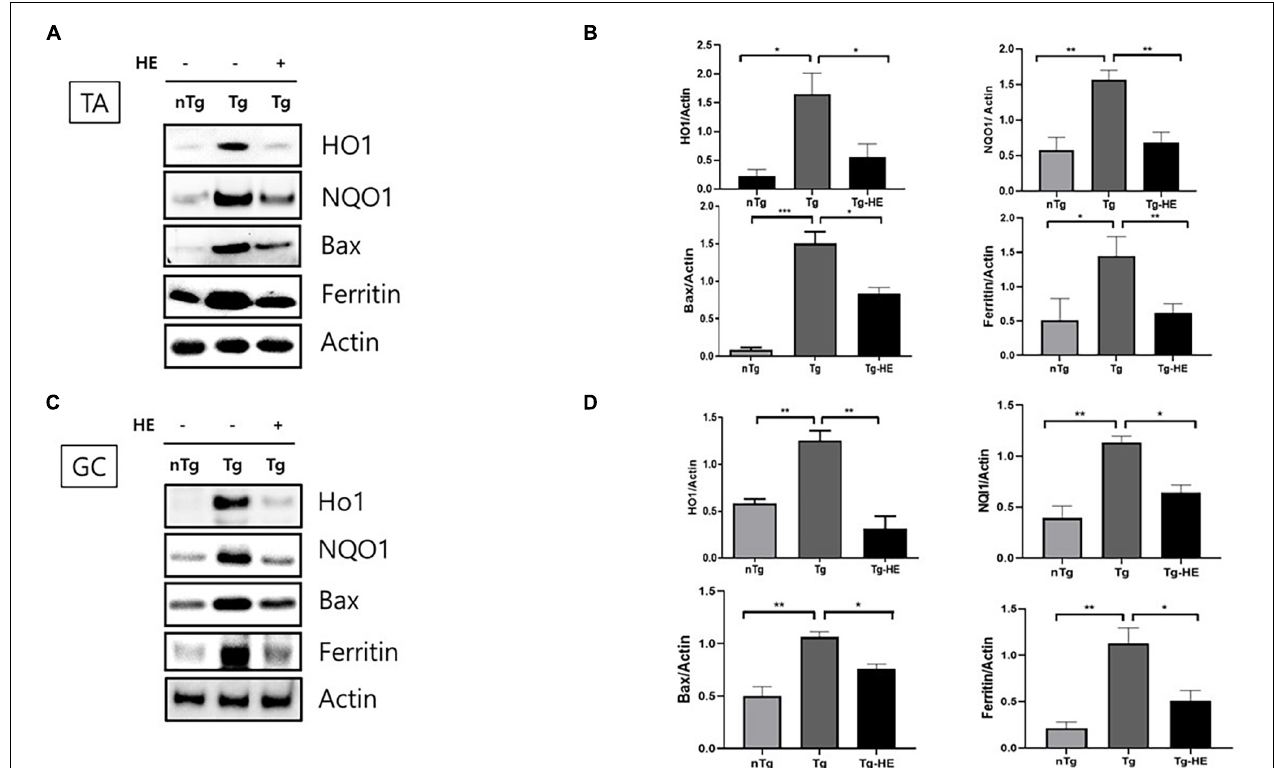
FIGURE 3 | Herbal extract (HE) reduces oxidative stress in the muscles of hSOD1 G93A mice. Representative data for Western blotting analysis of HO1, NQO1, BAX, and ferritin in the (A) tibialis anterior (TA) and (C) gastrocnemius (GC) using nTg, Tg, and Tg-HE ( N = 3); and quantitative analysis of the expression level of each protein in (B) TA and (D) GC. Data are shown as the mean ± SEM. The statistical analyses were conducted with a one-way ANOVA followed by Bonferroni’s multiple comparison tests (* p < 0.05, ** p < 0.01, and *** p < 0.001).